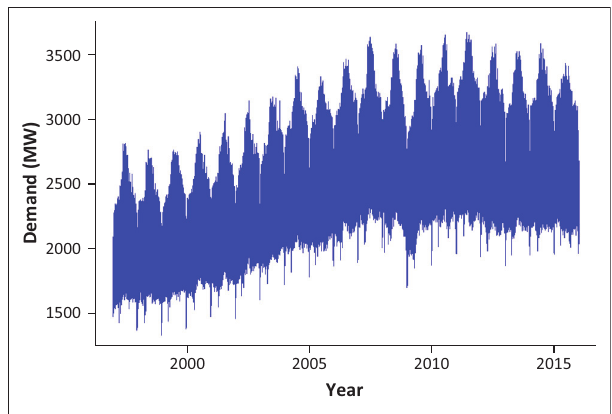
FIGURE 1: Electricity demand between 1997 and 2015 in South Africa.